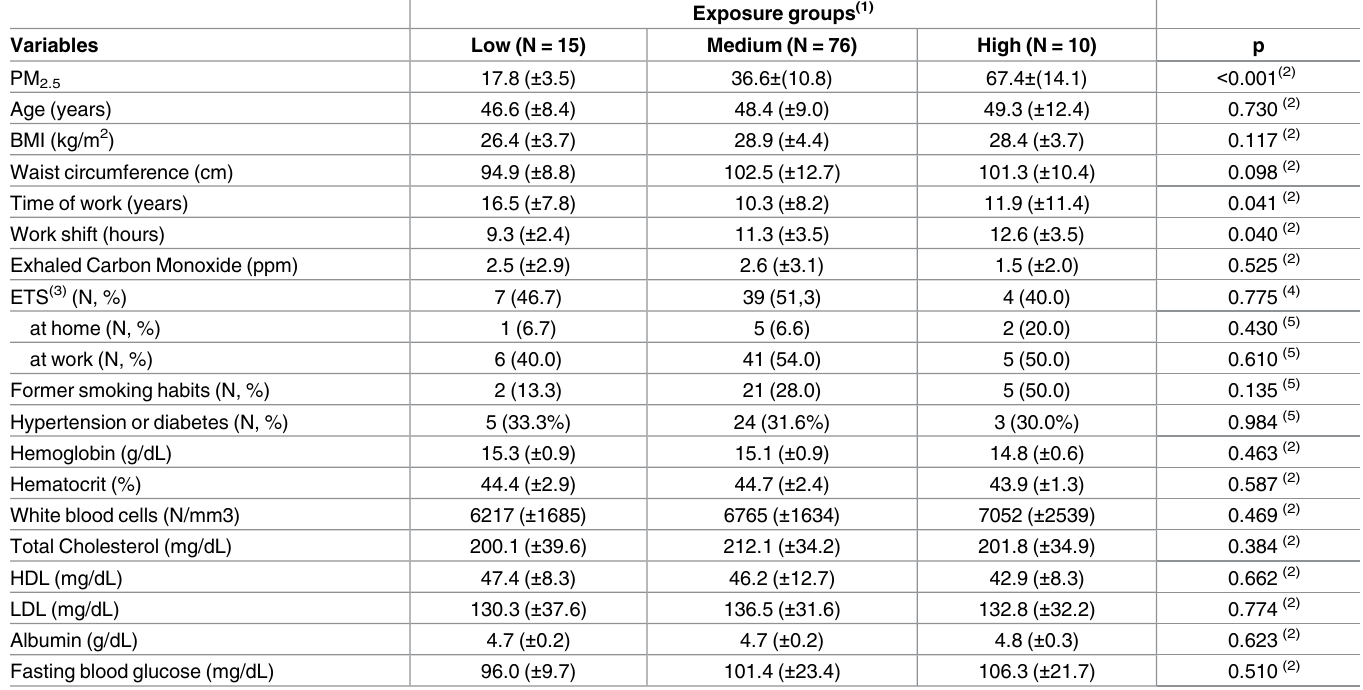
Table 1. PM 2.5 concentration and baseline characteristics of participants (N = 101).